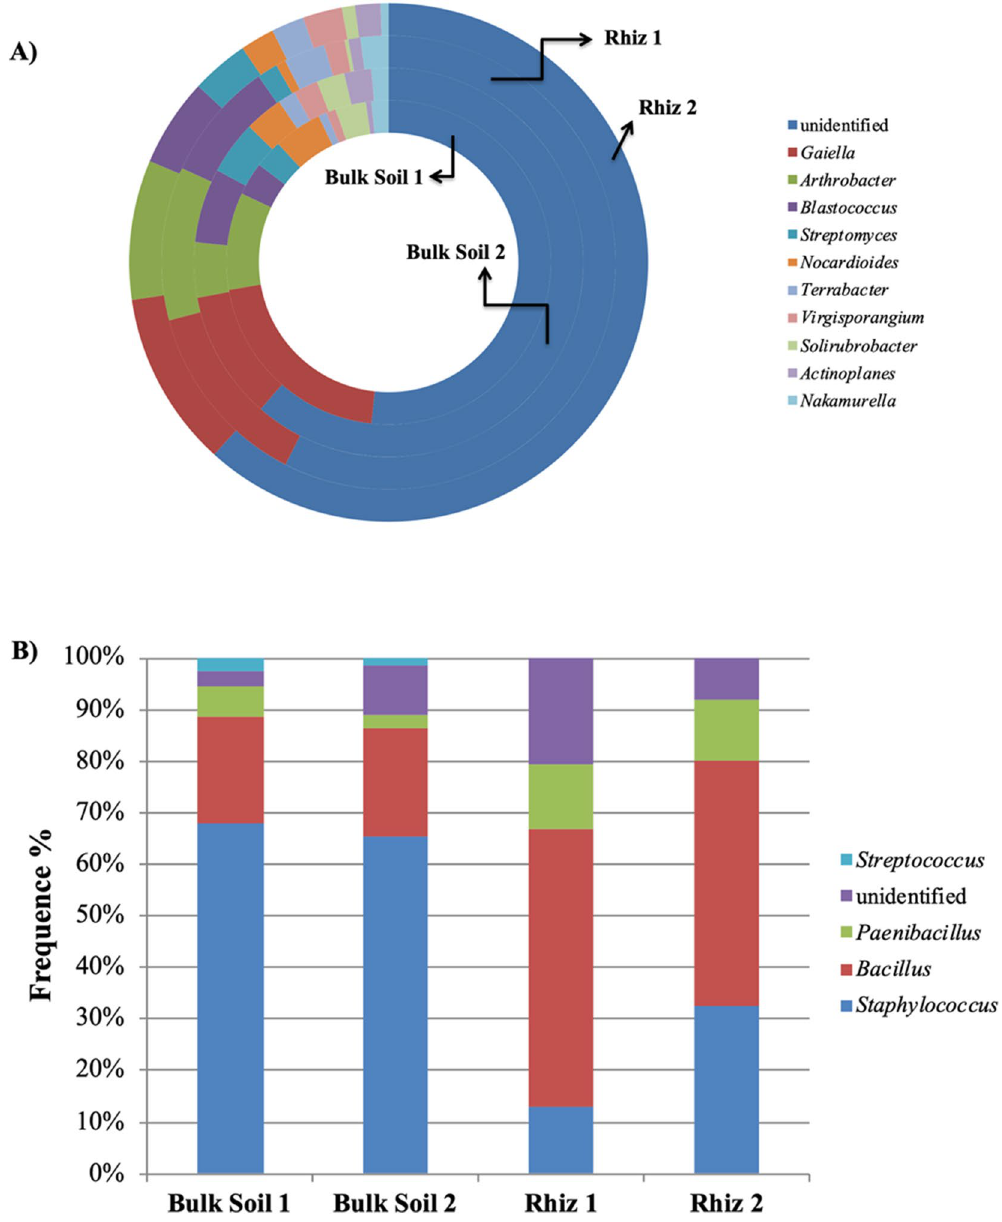
Figure 6. Distribution of the genera belonging to the class ( A ) Actinobacteria and ( B ) Bacilli, in bulk soil and rhizosphere of V. vinifera cv. Pinot Noir during the two sampling times (flowering and early fruiting stages). From the center to the edge Bulk Soil 1, Bulk Soil 2, Rhiz 1, Rhiz